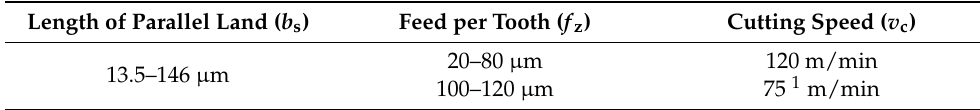
Table 3. Experimental Design (full factorial).